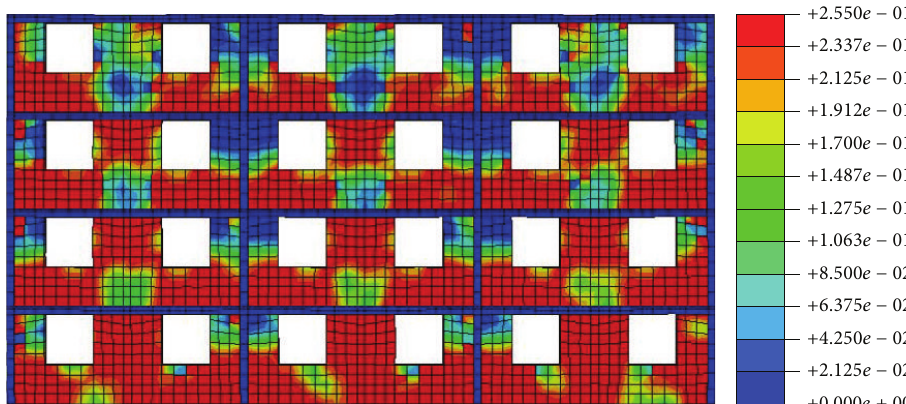
Figure 34: Tension crack damage cloud of model 3 under Wolong ground